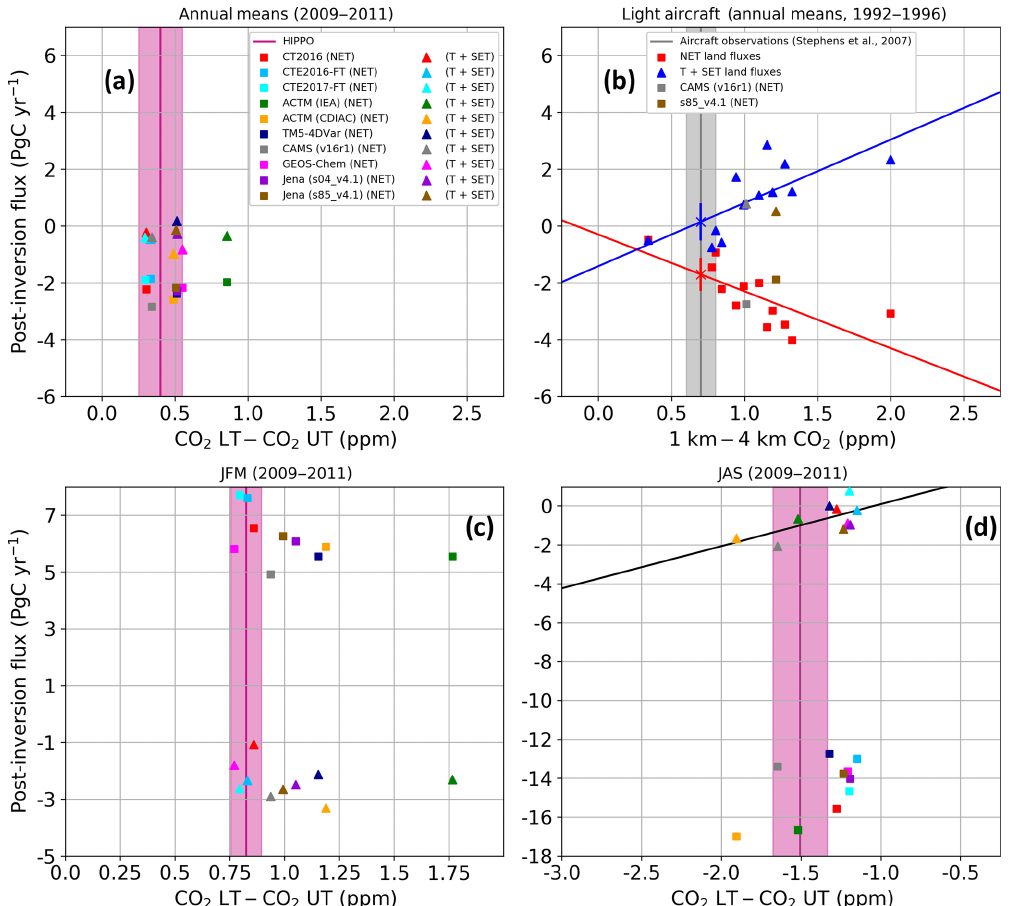
Figure 2. Retrieved fluxes versus NET vertical gradients. (a) Annual mean NET land and T+SET land fluxes versus posterior NET vertical gradients (lower minus upper troposphere) from model output along HIPPO flight tracks and HIPPO observations (pink line) for the period 2009–2011. The shaded area represents an estimate of measurement uncertainty of ± 0 . 15ppm for the annual mean, as estimated in the Sect. S2 in the Supplement. Inverse model posterior concentration gradients and fluxes are shown as points (squares represent NET; triangles represent T+SET). The vertical axis represents the integrated annual mean land fluxes (PgCyr − 1 ). (b) Same as (a) but for 1992–1996 and showing TransCom 3 Level 2 models and our two current models that span this time period, showing dependence of posterior fluxes on transport and a large range of transport biases. Annual mean NET (red squares) and T+SET (blue triangles) land carbon fluxes for 1992– 1996 estimated by the 12 T3L2 models plotted as a function of the models’ post-inversion predicted mean vertical CO 2 gradients at 10 light-aircraft profiling sites (adapted from Stephens et al., 2007) with fluxes partitioned by TransCom region. The Jena (s85_v4.1) and the CAMS (v16r1) simulations have also been sampled at the same light-aircraft locations but their fluxes are partitioned at 20 ◦ N and 20 ◦ S. The crosses show our new best estimate of the fluxes estimated by the regression of all T3L2 models. The error bars on these points are estimated using the standard error of the regressions. (c) Same as panel (a) for January–February–March (JFM), and (d) same as panel (a) for July–August–September (JAS). For the seasonal plots, the width of the pink bar is 0.07ppm for JFM and 0.17 for JAS. In panel (d) , the black line represents the regression line, shown because the relationship is statistically significant at a 95% confidence